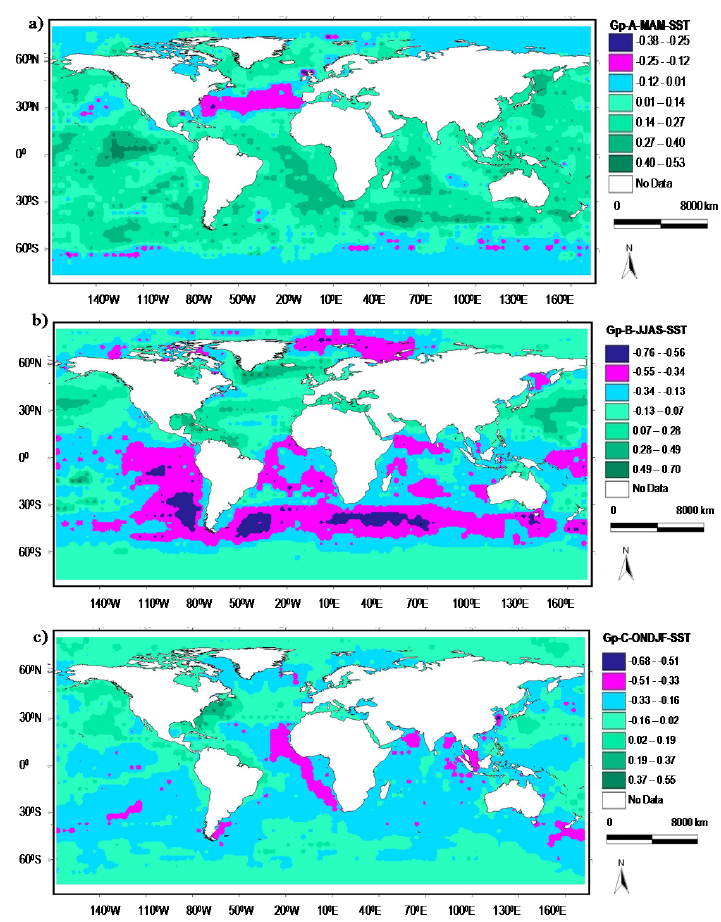
Figure B1. Correlation between season-based SST and region-wide rainfall for group (a) A, (b) B, (c)